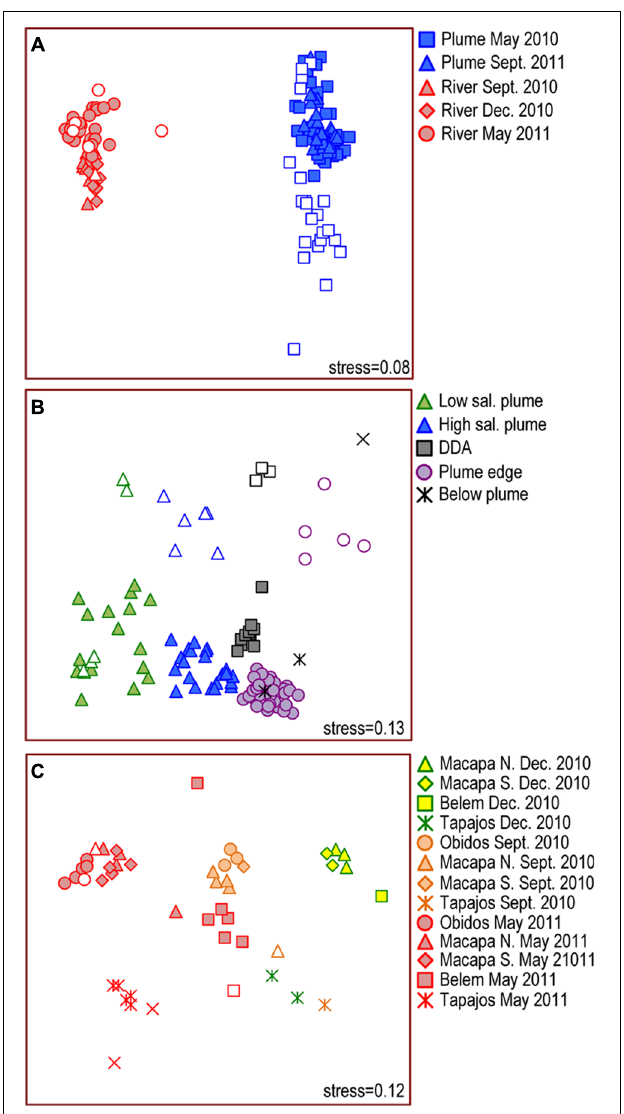
FIGURE 2 | Multidimensional Scaling (MDS) diagrams showing Bray–Curtis similarity among bacterial communities in (A) all samples collected in the Amazon River and Plume in 2010 and 2011, (B) Amazon plume samples, and (C) Amazon River samples. Closed symbols represent unfractionated samples and free-living bacteria (0.2–2.0 µ m). Open symbols represent particle-attached bacteria ( > 2.0 µ